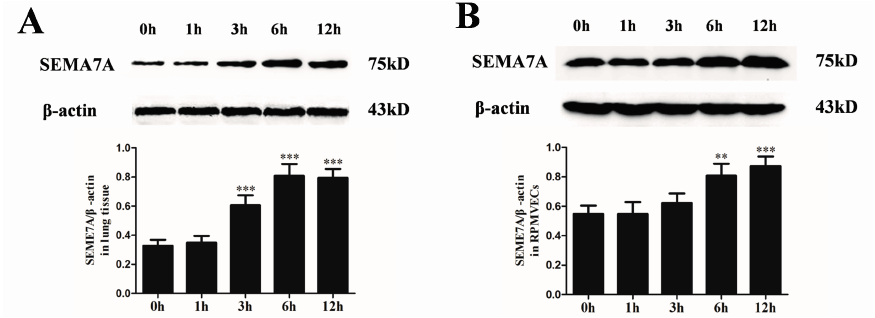
Figure 2. Changes of Semaphorin 7A (SEMA7A) expression in seawater aspiration-induced acute lung injury (ALI) in lung tissues ( A ) and rat pulmonary microvascular endothelial cells (RPMVECs) ( B ). Samples were obtained at 0, 1, 3, 6 and 12 h after seawater exposure. n = 8, ** p < 0.01, *** p < 0.001 versus 0 h